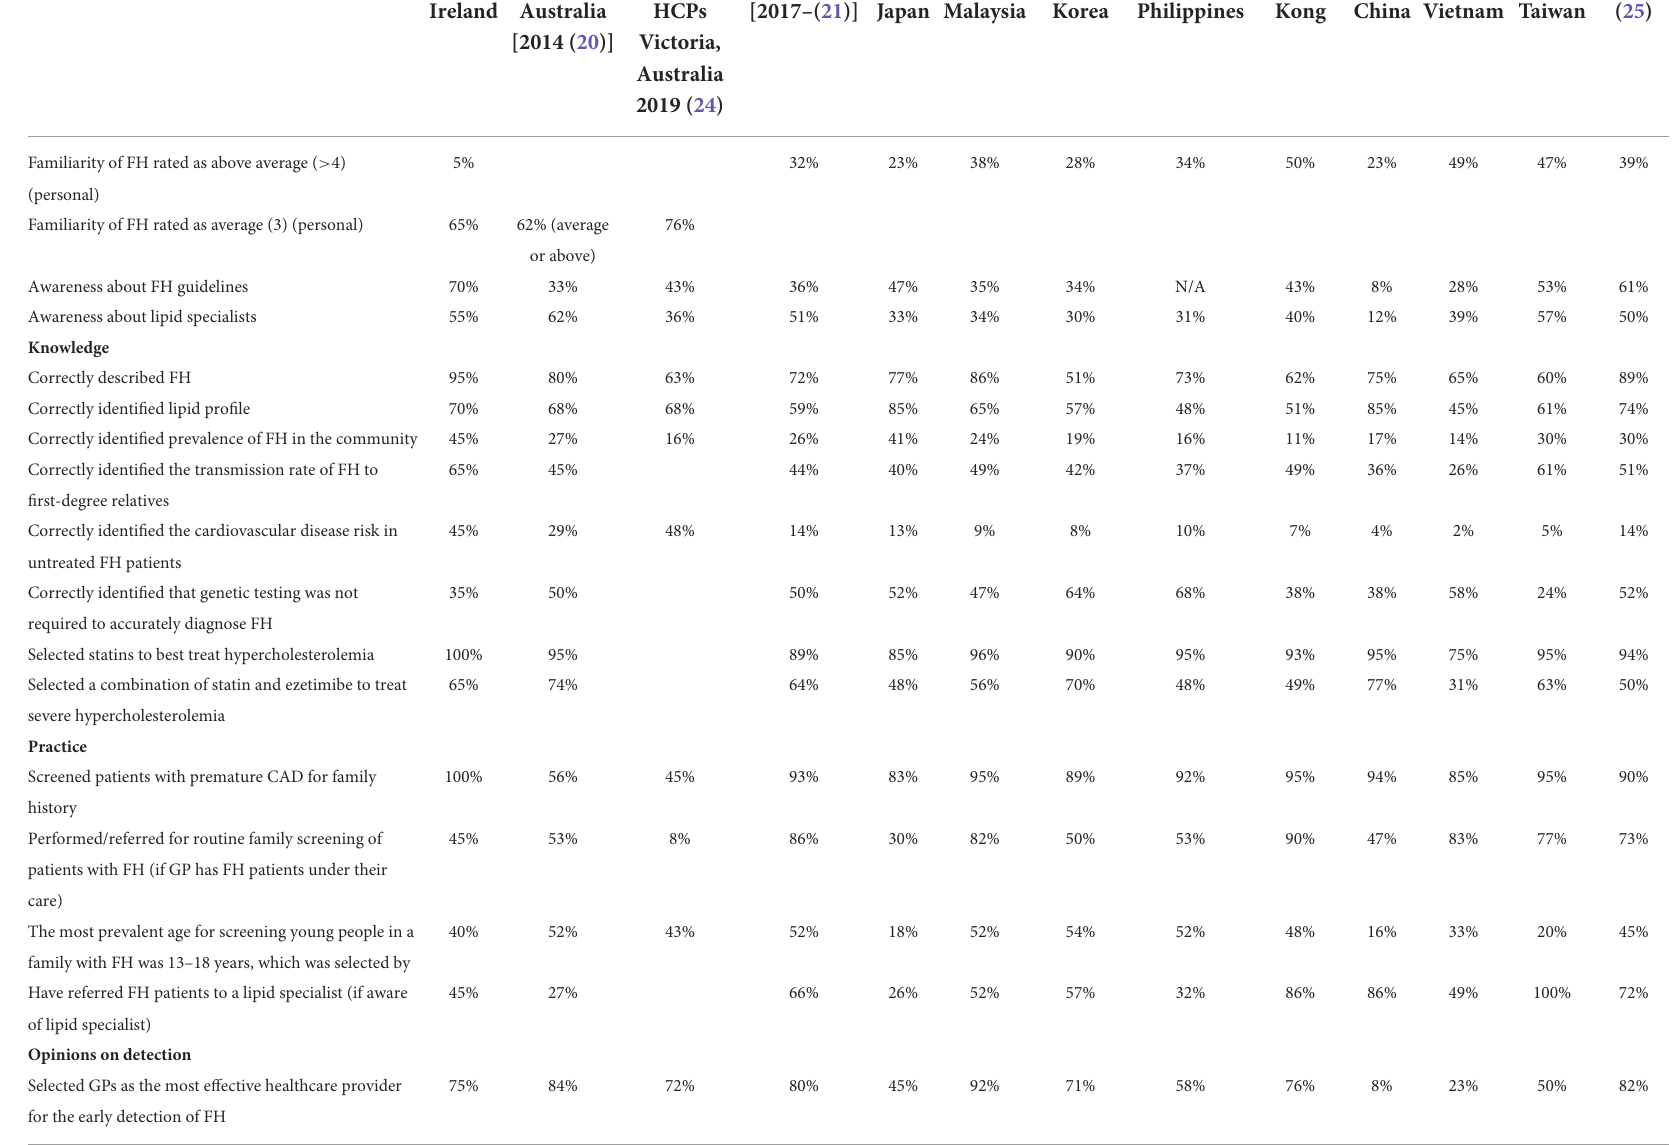
TABLE 11 Awareness and knowledge survey response